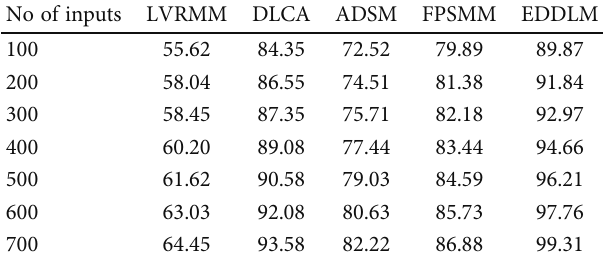
Table 7: Heat supply management.